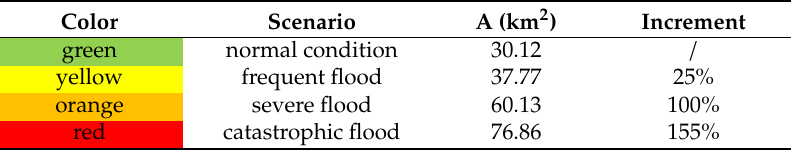
Table 7. Total flood-prone areas and percentage increment from the normal condition to the di ff erent flood hazard scenarios. Color Scenario A (km 2 ) Increment green normal condition 30.12 yellow frequent flood orange severe flood red catastrophic flood 76.86